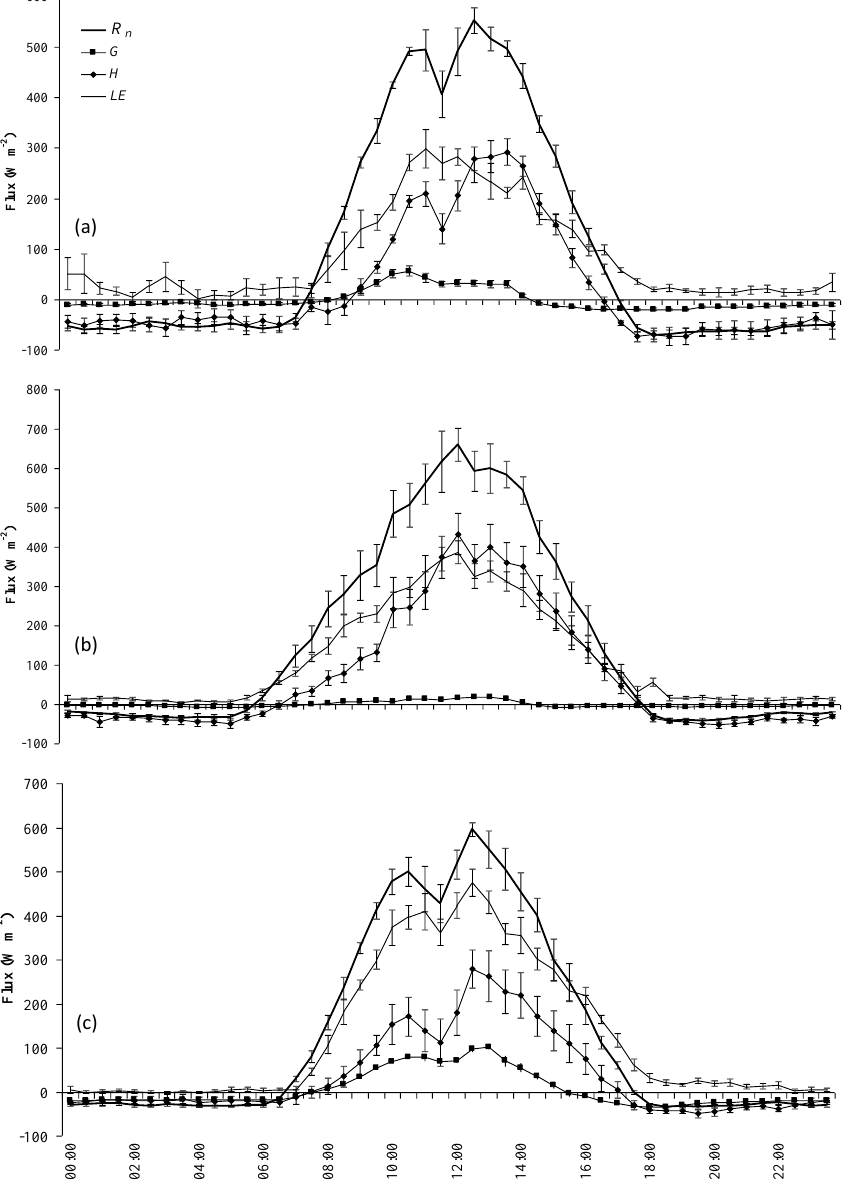
Figure 5. The average of the half-hourly energy fluxes, with error bars indicating the standard error, measured at the Nkazana Swamp Forest in (a) August 2009, (b) November 2009 and (c) March